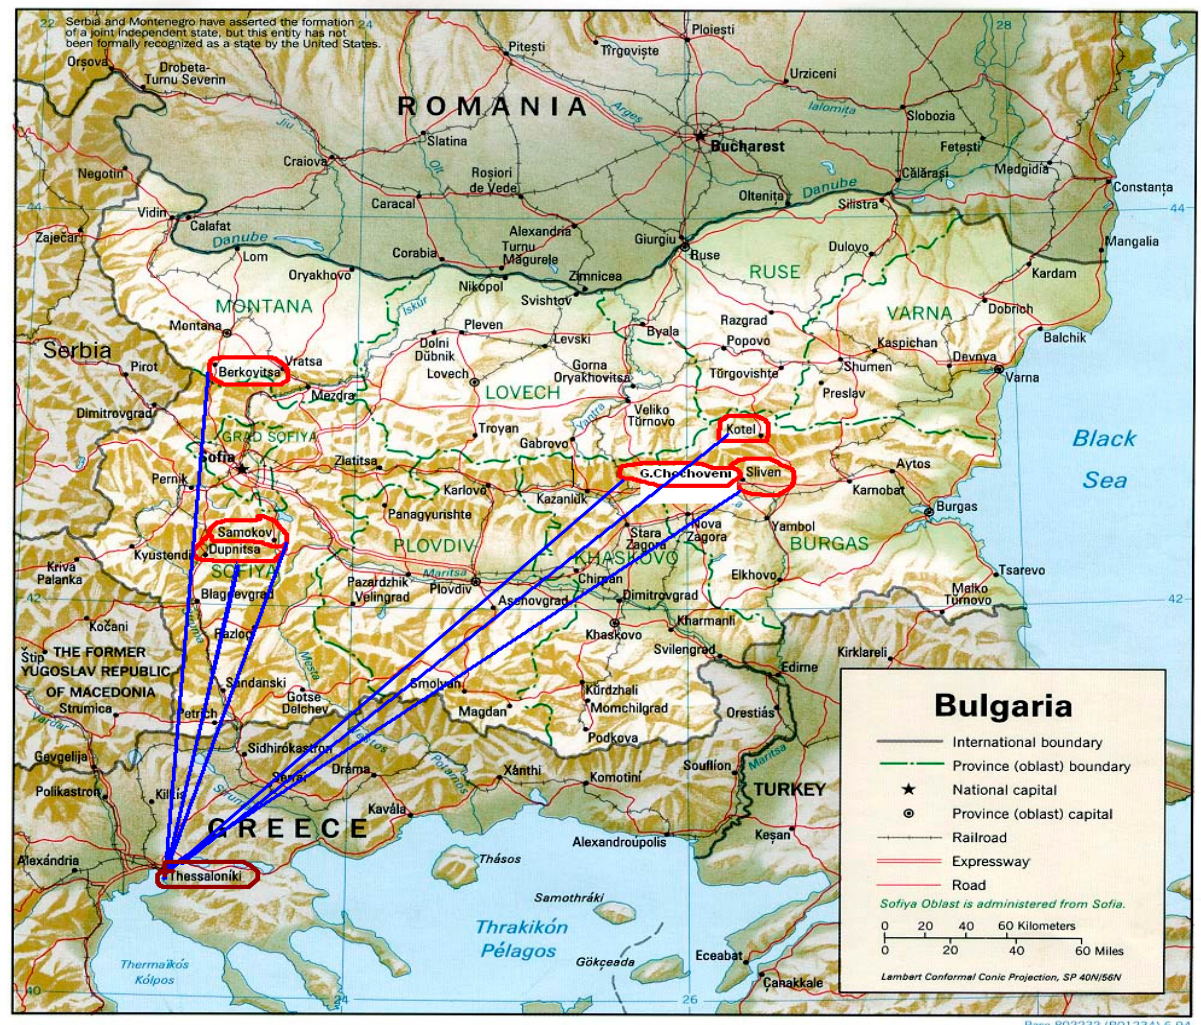
Figure 1. The areas of my field research (the explanations for the blue lines and red circles can be seen in the paragraph above)